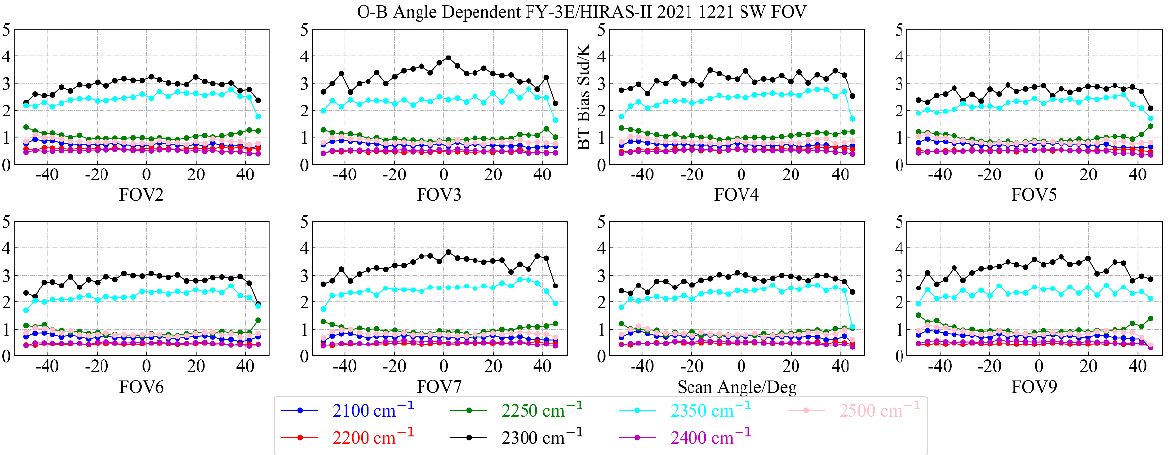
Figure 19. Distribution of OMB standard deviation of 9 FOVs of typical short-wave channels as a function of scanning angle.